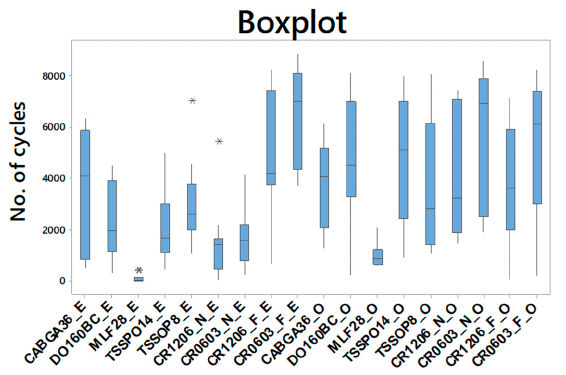
Figure 10. Boxplot analysis showing statistical outliers marked with asterisks. The outliers were not considered in further analysis. The component nomenclature is defined in Table